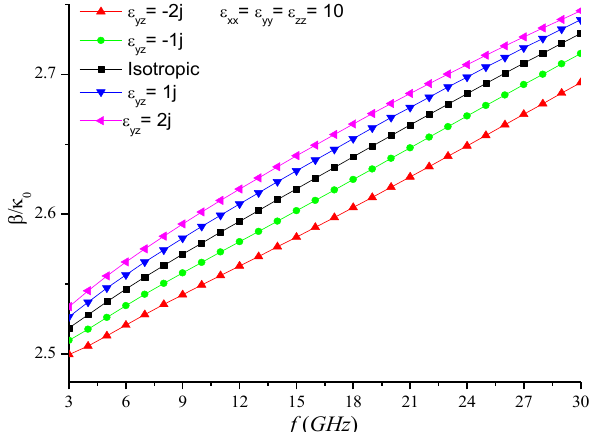
Figure 8.a: Effect of imaginary valued e yz the normalized phase